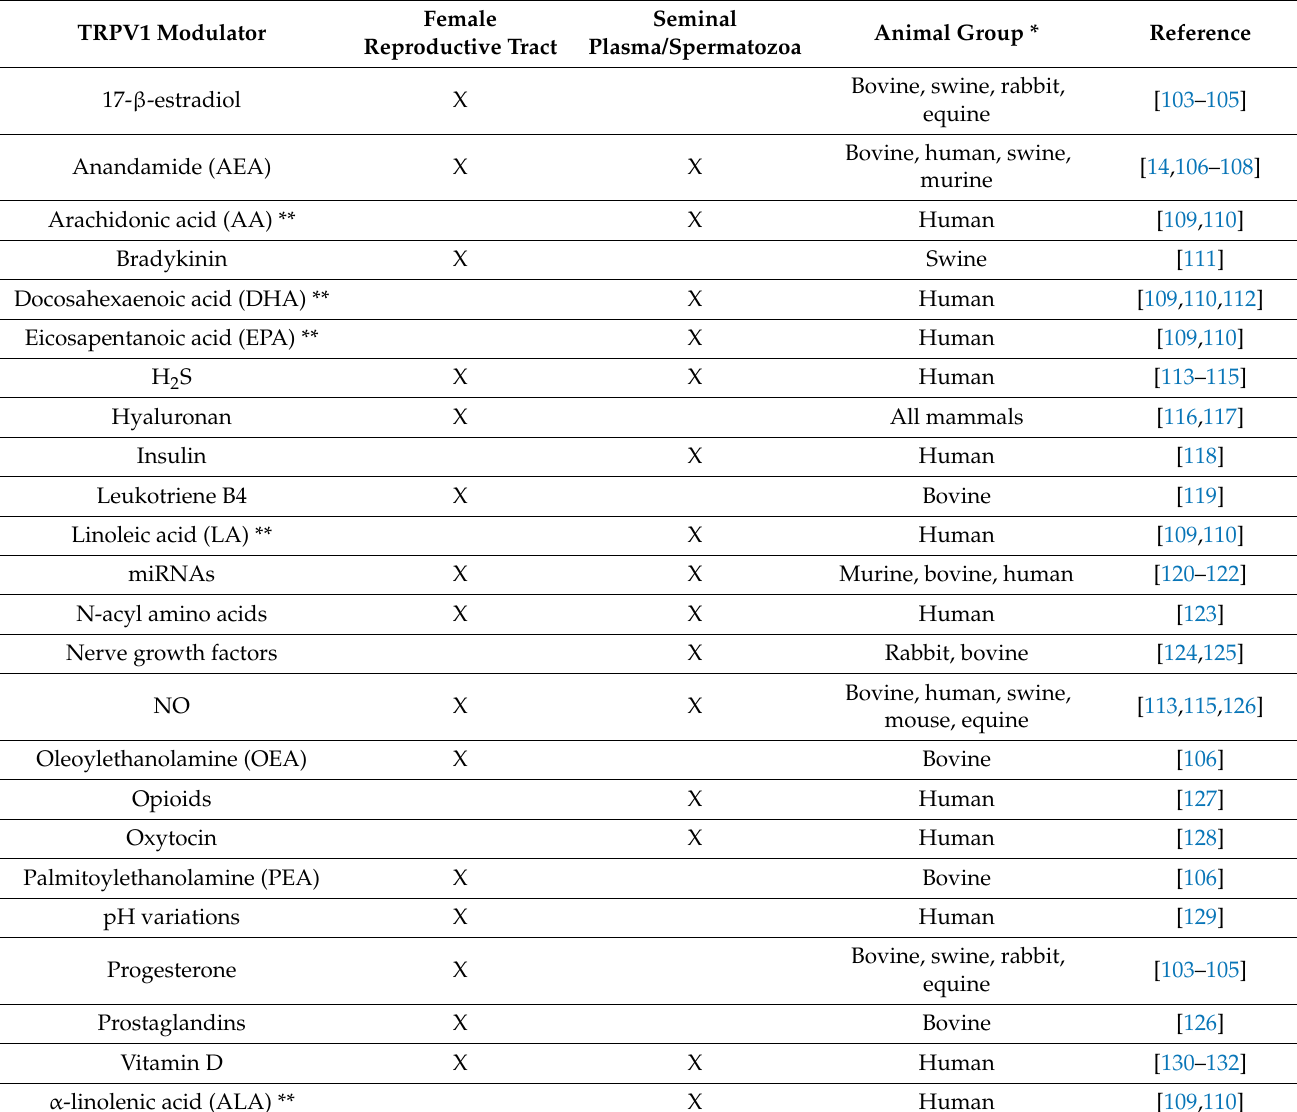
Table 2. Modulators of TRPV1 function found in the female reproductive tract, seminal plasma, or spermatozoa in different